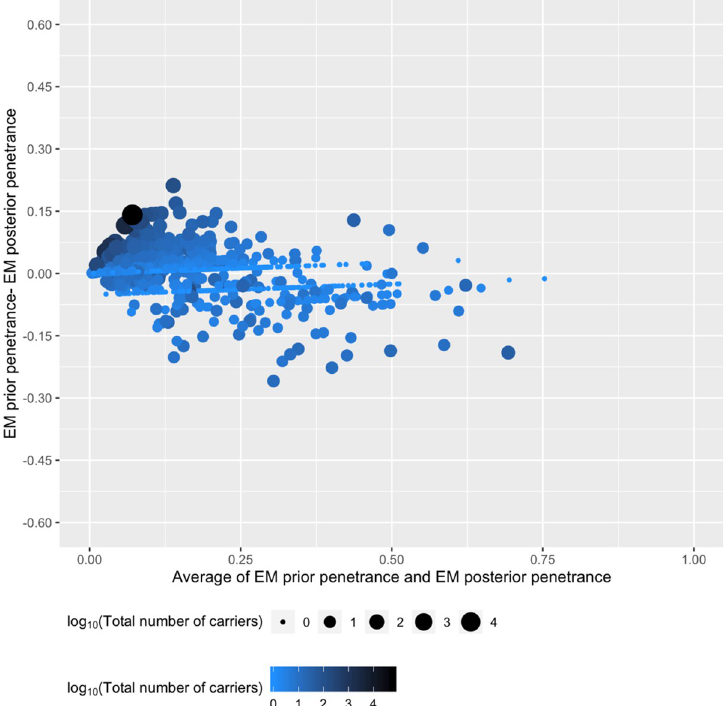
Fig 2. Bland-Altman plot between EM prior and EM posterior mean penetrances for all SCN5A variants. To assess the performance of the EM prior, we used a Bland-Altman plot to compare the mean BrS1 penetrance estimated from the EM prior and from the EM posterior, the y-axis is the difference between the two and the x-axis is the average between the two. For each plotted point, both color and radius indicate the log 10 of the total number of heterozygotes present in the dataset. The relatively consistent scatter about y = 0 suggests no systematic biases present in the EM prior mean BrS1 estimates.